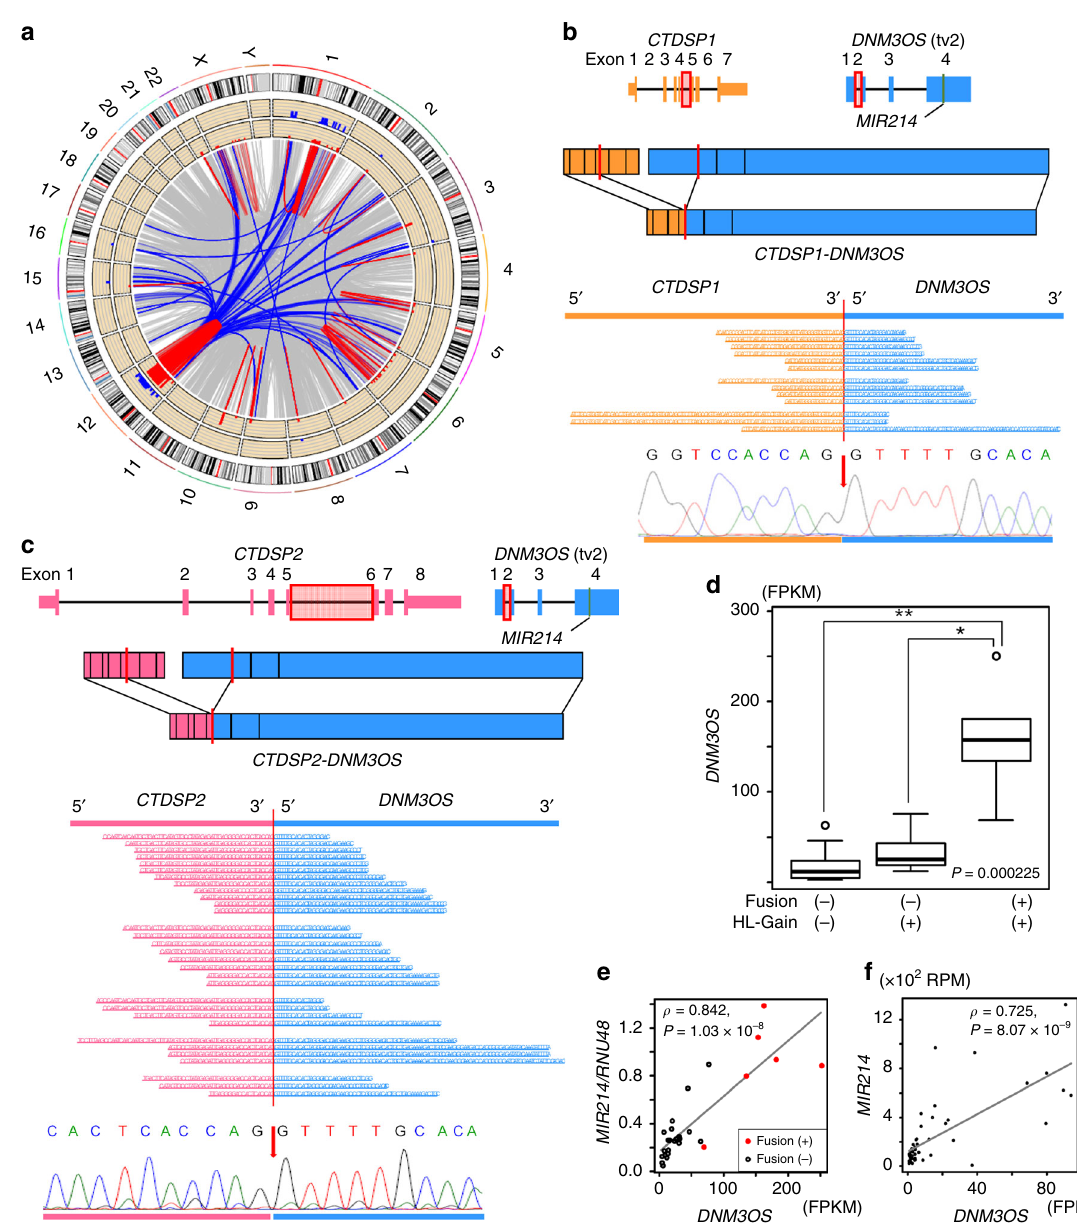
Fig. 2 Chromosomal rearrangements and fusion genes in DDLPS. a Circos plot of chromosomal rearrangements across 103 DDLPS tumors. The central circle displays structural rearrangements of the fusion genes. The red and blue lines indicate intra- and interchromosomal rearrangements, respectively, which were recurrently observed in at least six cases, while the gray lines show those which were observed in less than six cases. Case count at each gene was performed by referring to the number of partner-genes; a gene rearranged with multiple positions in one case was recognized as different cases. The second and third inner circles represent the histograms of the cases with intra- and interchromosomal rearrangements, respectively, of the genes at the indicated positions. The range of the axis for the counts of the cases in each histogram is from 0 to 60. b , c Schematic of CTDSP1-DNM3OS ( b ) and CTDSP2-DNM3OS- ( c ) fusion genes. The region in the red box includes the genomic breakpoint, and the red vertical bars denote the breakpoints in the mRNA (upper panel). Supporting reads (middle) and sequencing chromatogram (lower) of CTDSP1-DNM3OS from three DDLPS tumors. The red arrow represents the breakpoint. d DNM3OS expression in DDLPS. DDLPS tumors from the JSGC-NCC cohort were classi fi ed according to their DNM3OS-fusion status and the high-level copy-number gain (HL-Gain) of DNM3OS . The box signi fi es the upper and lower quartiles; the center bold line within the box, median; the upper and lower whiskers, upper and lower quartiles + / − interquartile ranges, respectively. * P <0.05 and ** P <0.01 by Steel-Dwass test. e , f Pearson correlation tests and scatter plots showing the relationship between the expression of MIR214 and DNM3OS in JSGC-NCC ( e ) and TCGA ( f ) tumors. The expression of MIR214 and DNM3OS in 30 and 52 DDLPS tumors from JSGC- NCC and TCGA, respectively, was analyzed. The red dots represent DNM3OS -fusion-positive samples. P -values, derived from Pearson ’ s rank correlation